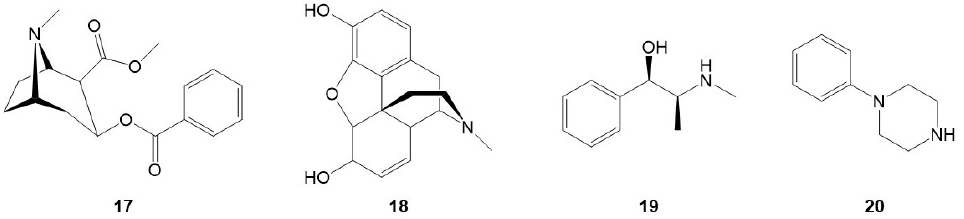
Figure 7. Chemical structures of illicit drugs used in competition and selectivity studies for 1 -based MIPs: cocaine ( 17 ), morphine ( 18 ), ephedrine ( 19 ) and phenylpiperazine ( 20 ).